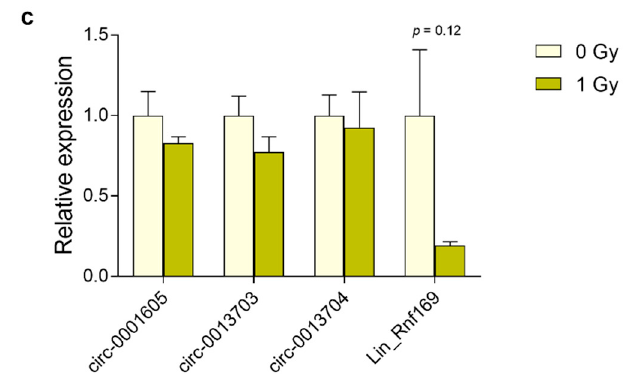
Figure 9. Radiation-induced RNA abundance in mouse blood. Relative levels of linear and circular ( a ) Pvt1; ( b ); Sec14l5; and, ( c ) Rnf169 transcripts were determined by RT-qPCR at 10 days after whole body irradiation of female mice. Data shown are means + s.e.m. of three biological replicates ( n = 3) and have been normalized against 0 Gy. Statistics were performed using Student’s t -test; * p < 0.05; ** p < 0.01.